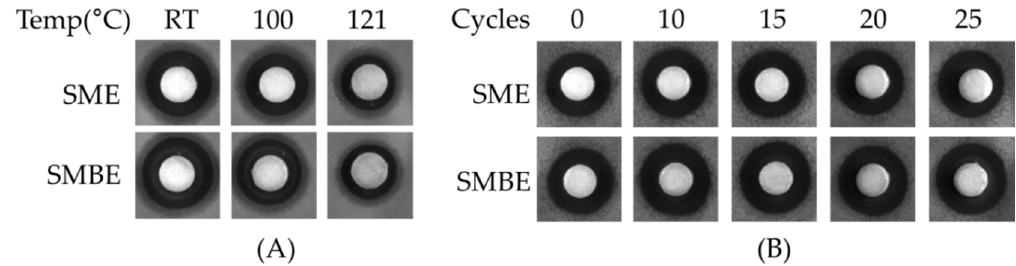
Figure 1. ( A ) Antibacterial activity against B. cereus by heat treatment of S. miltiorrhiza ethanol extracts. Each sample was incubated at 100 °C or 121 °C for 15 min. ( B ) Antibacterial activity against B. cereus in accordance with freeze-thaw cycles of S. miltiorrhiza ethanol extracts. Each sample was repeated for 25 cycles of freezing and thawing.